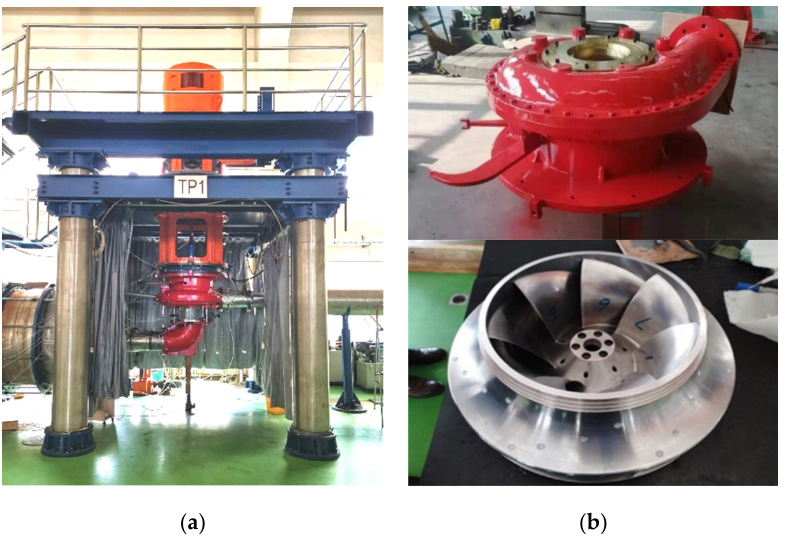
Figure 15. TP1 Hydraulic turbine model test bench: ( a ) test bench; ( b ) view of the model of the tested machine and its runner.